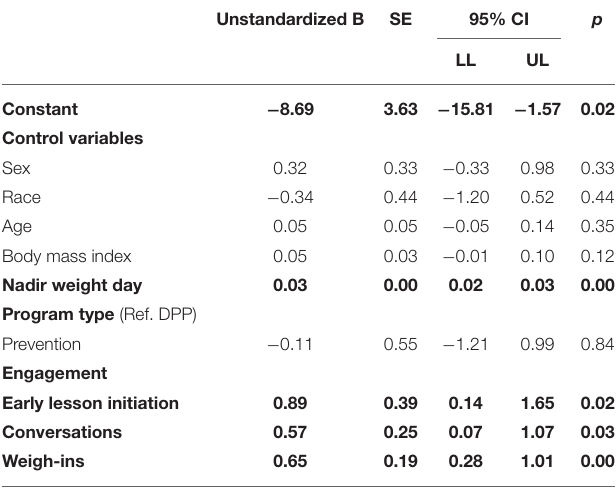
TABLE 2 | Results of the regression modeling the effect of engagement on weight loss